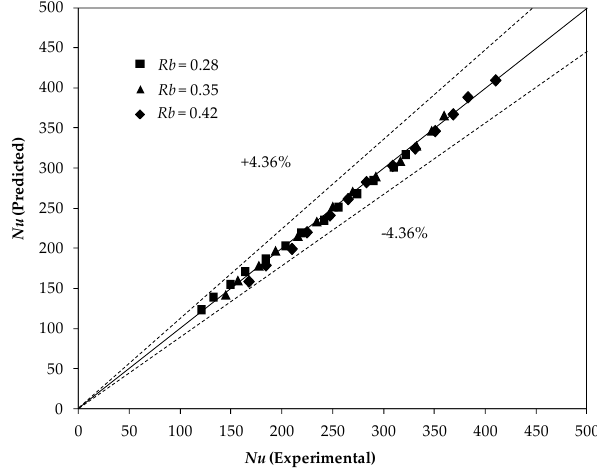
Figure 9. Comparison between the experimental Nu with predicted Nu .